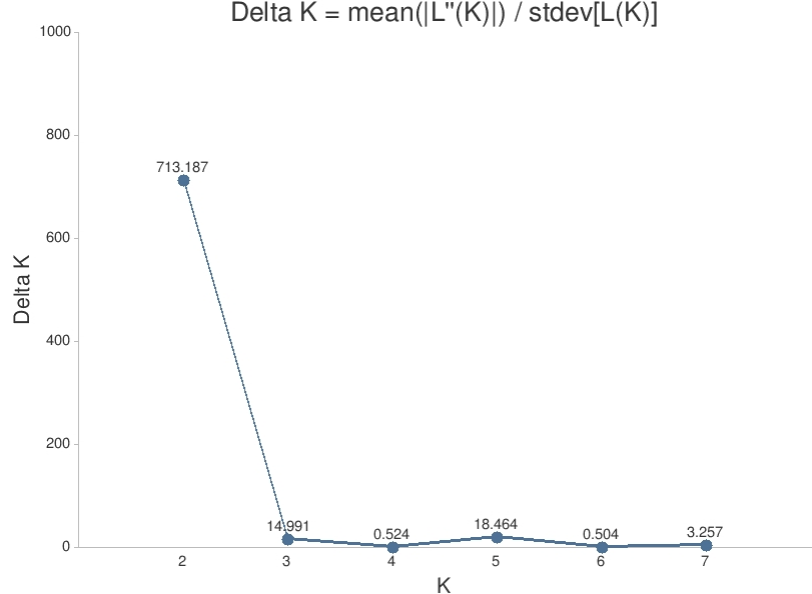
Figure 4. Delta K values for the results of the analysis with STRUCTURE.